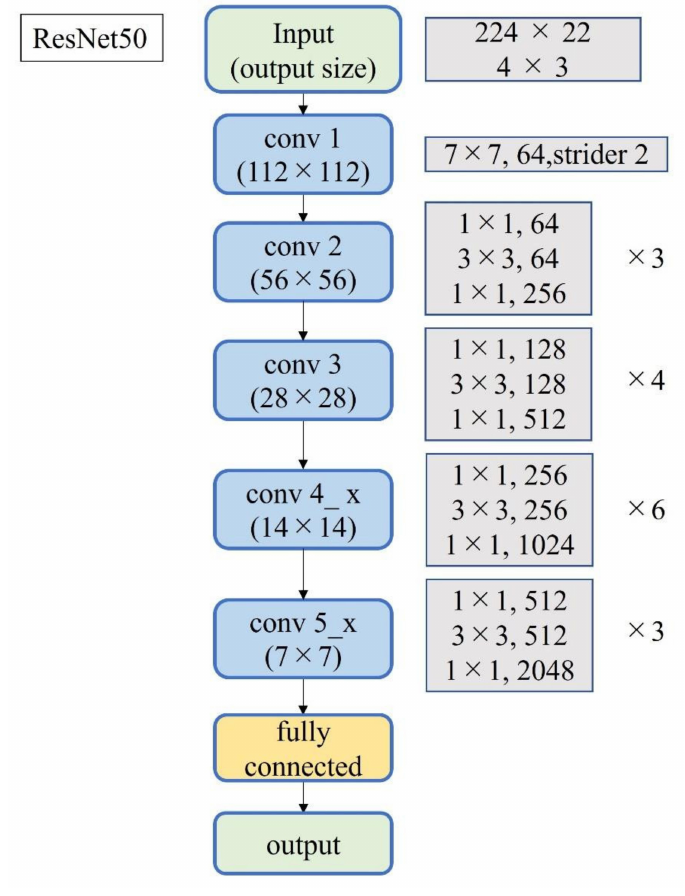
Figure 4. Block diagram of